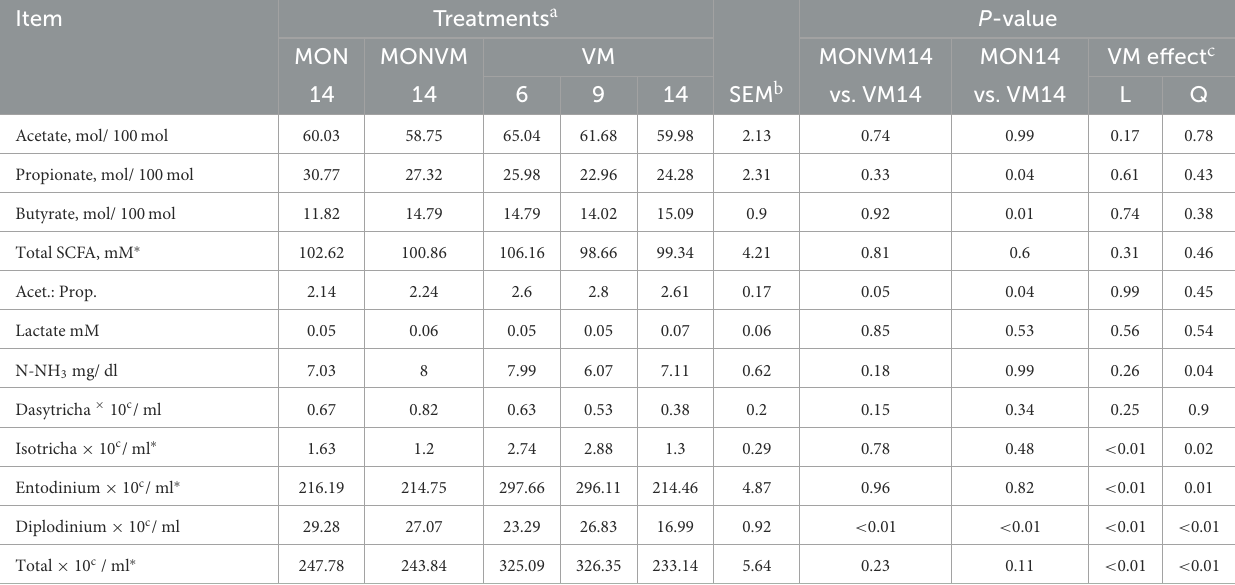
TABLE 4 Evaluation of ruminal fermentation products and differential protozoan counting of rumen cannulated Nellore cattle fed high-concentrate diets containing sodium monensin (MON), virginiamycin (VM), or both on the 16th day of the experimental